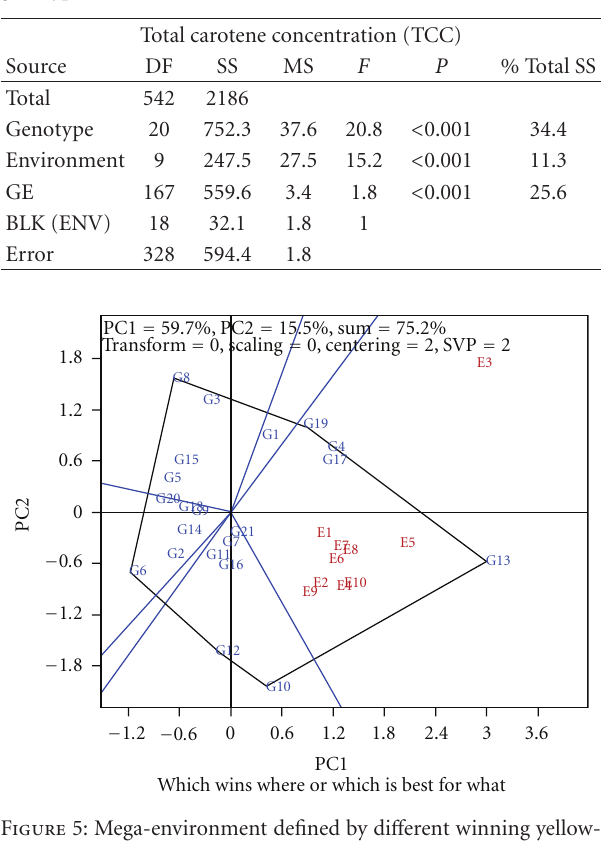
Table 6: Combined analysis of variance table of genotype, envi- ronment, and genotype by environment contributions to the sum of squares of total carotene concentration of 21 yellow-fleshed genotypes in 10 environments.